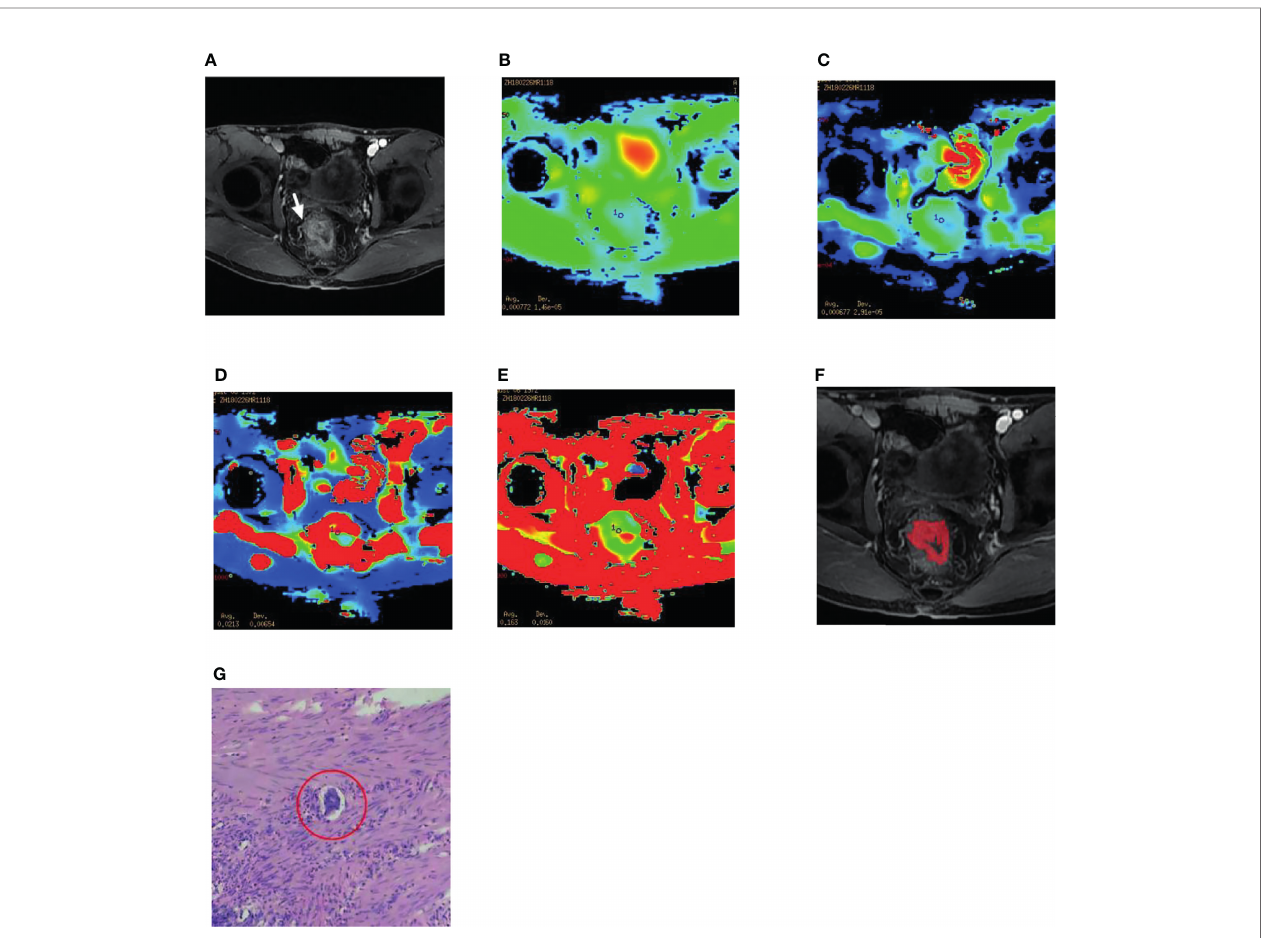
FIGURE 1 | A 45-year-old male patient with rectal adenocarcinoma. (A) The right lateral wall of the rectum was invaded, and the origin of the vessels was changed (white arrow). (B – E) After selecting the ROI on the DWI image, the IVIM-DWI parameters ADC,D,D* and f value were obtained. (F) Texture analysis, The radiologist mapped the ROI on the maximum size of the lesion. (G) The postoperative specimen of this patient is con fi rmed by pathology to be differentiated Adenocarcinoma of Rectum and EMVI positive, ulcerated, and the red circle shows intravascular cancer embolus (HE